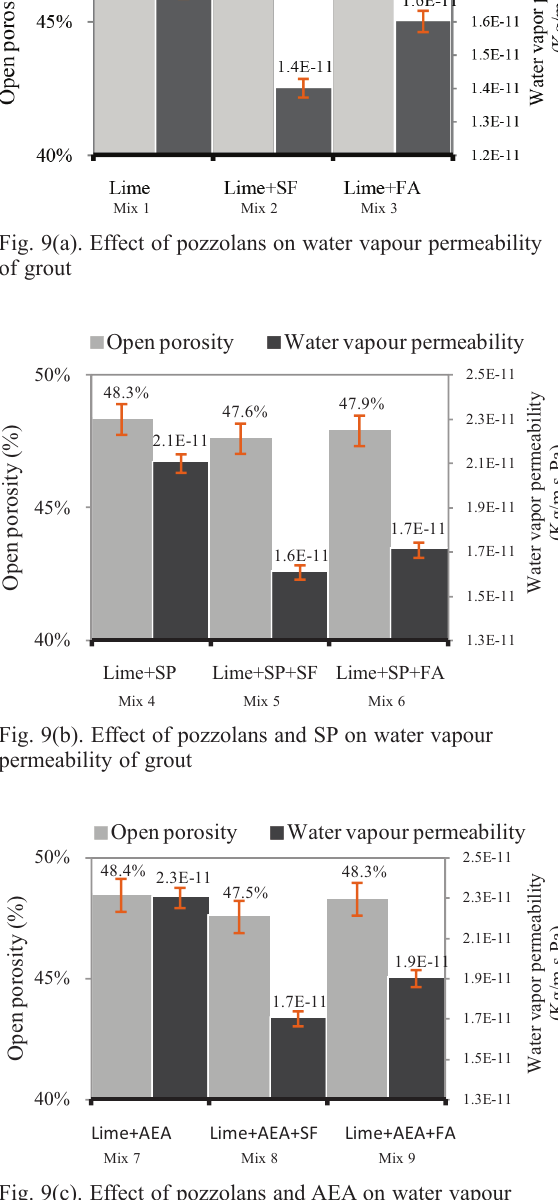
Fig. 9(c). Effect of pozzolans and AEA on water vapour permeability of grout